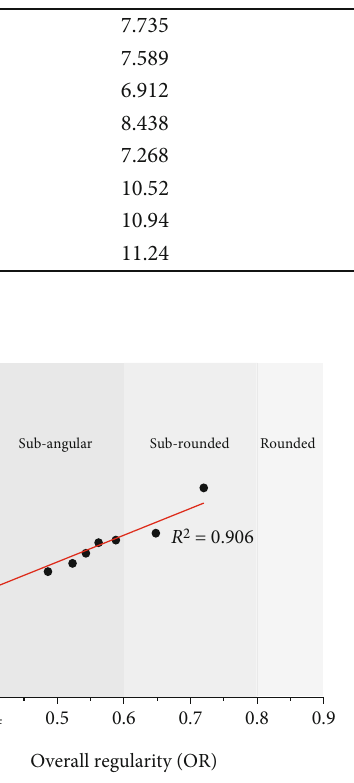
Figure 8: Curve fi tting for overall regularity (OR) versus a F min / a sieve .